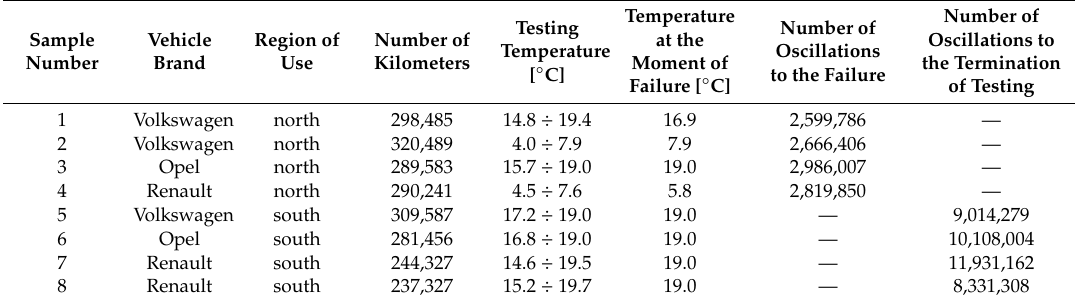
Table 5. The results of testing cu ff s at temperatures from 4 ◦ C to 20 ◦